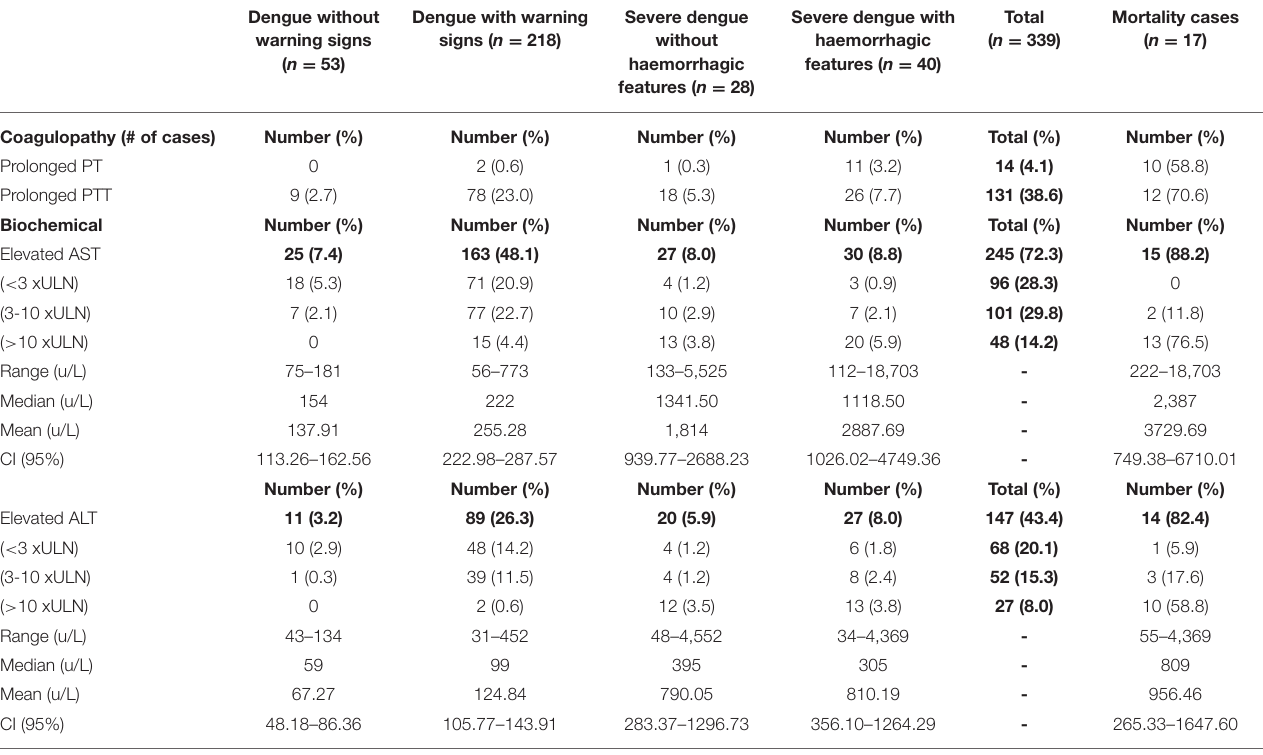
TABLE 5B | Laboratory investigations in pediatric patients hospitalized with suspected and confirmed dengue in the 2018–2019 epidemic.